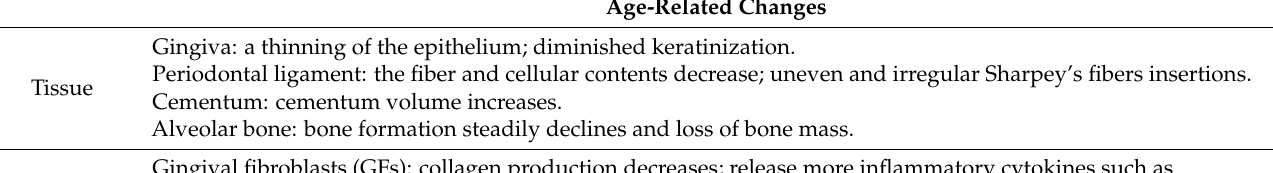
Table 1. The effects of aging on periodontium. Age-Related